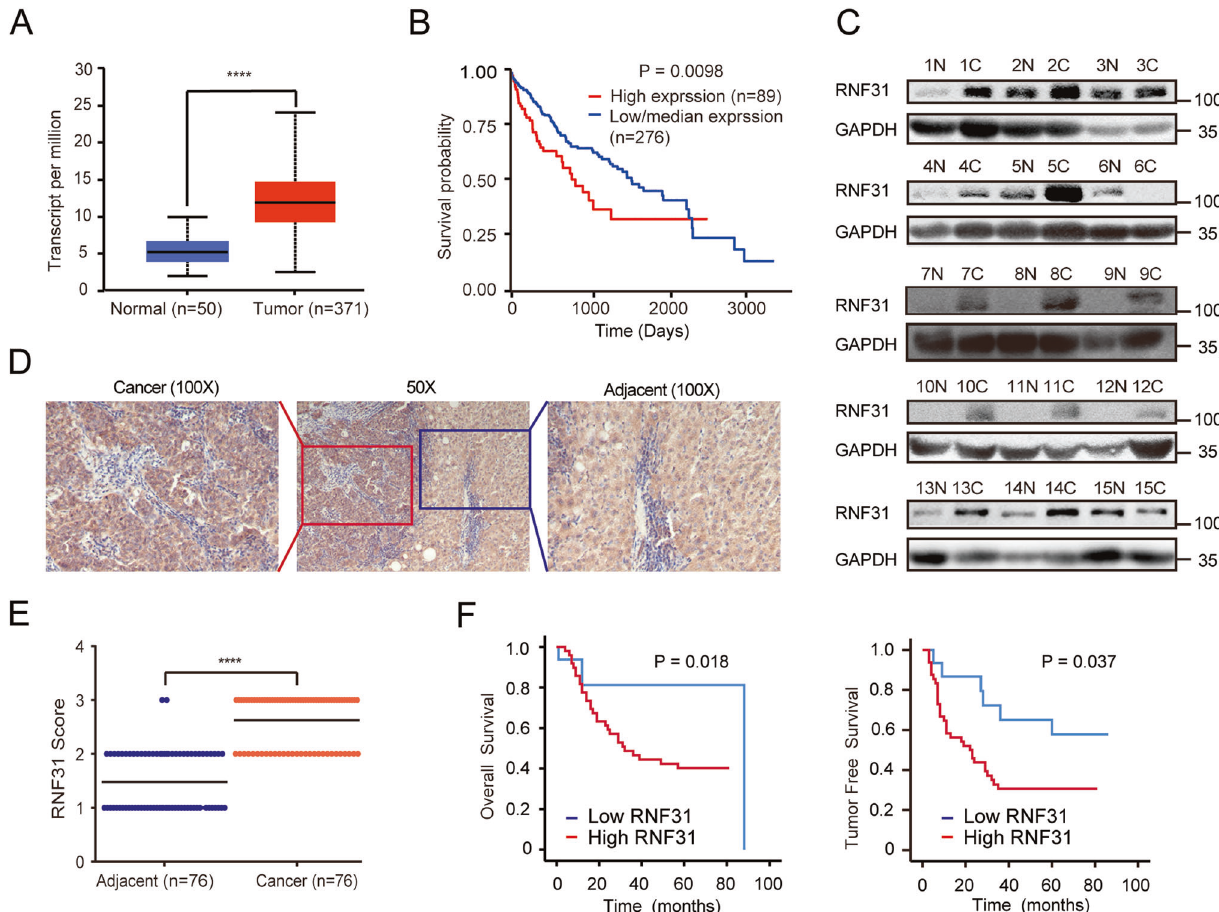
Fig. 1 RNF31 is overexpressed in human HC tissues and its expression correlates with patient prognosis. A RNF31 mRNA expression in human HCC tissues and normal liver tissues from TCGA database. B Kaplan – Meier analysis of overall survival curves for the RNF31 low and high expression human HCC cases in the TCGA. C RNF31 protein expression in pairs of HCC and corresponding noncancerous liver tissues from 15 patients were analyzed by western blot. D Typical IHC picture of RNF31 in paired HCC and corresponding noncancerous liver tissues. E IHC assay was performed to detect RNF31 expression levels in HCC tissues and adjacent noncancerous liver tissues. Immunohistochemical score were analyzed using Wilcoxon ’ s test ( n = 76, **** p < 0.001). F Overall survival and tumor-free survival of HCC patients were analyzed by Kaplan – Meier survival analysis (log-rank test). The patients were divided into two groups based on the immunohistochemical score of RNF31 in